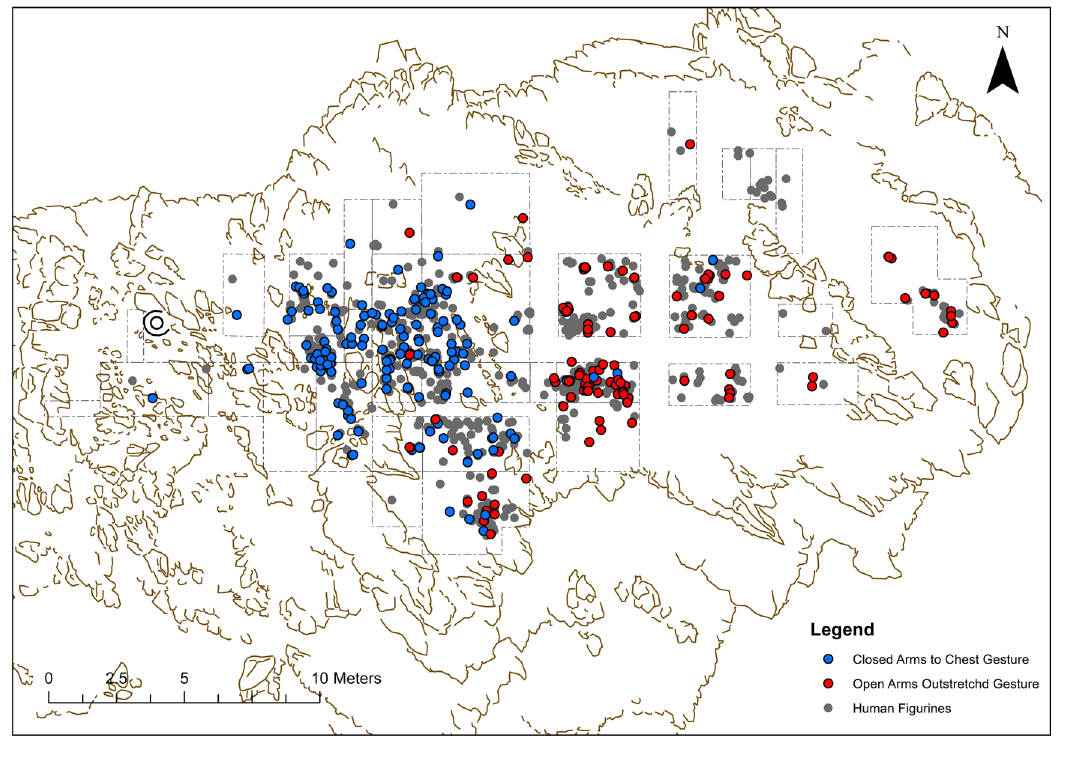
Figure 7: GIS mapping of the overall distribution of human figurine fragments, and showing the spatial distribution of figuri- nes performing open or closed gestures.